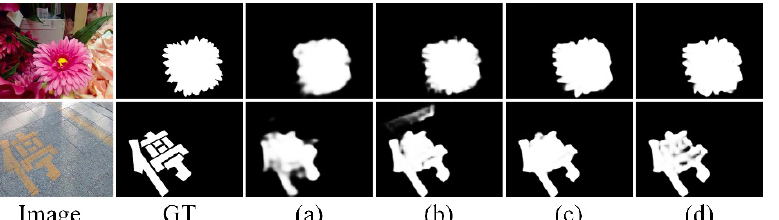
Figure 6. Visual comparison of different edge feature extraction approaches. ( a ) denotes the baseline network with no edge features extracted. ( b ) represents using a convolutional layer to extract edge features from AiF images. ( c ) means using EFEM to extract edge features from FS. ( d ) denotes using EFEM to extract edge features from AiF images.